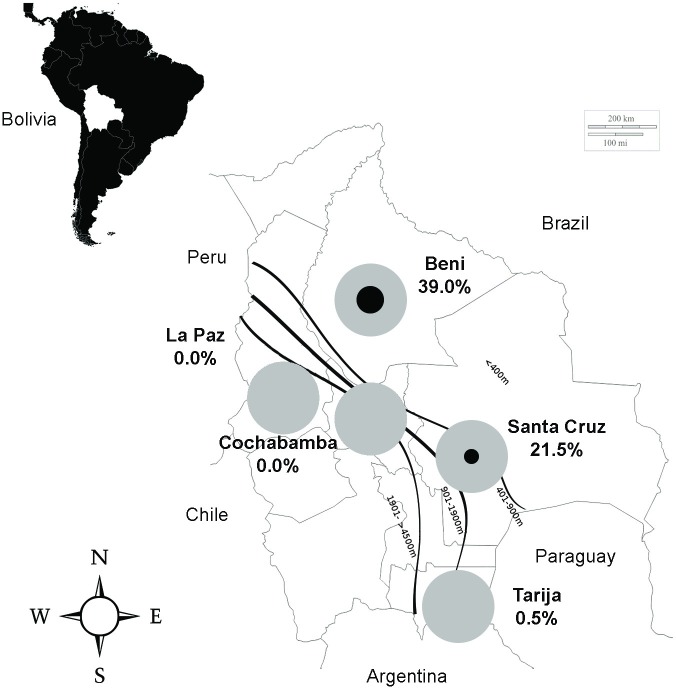
Zika virus seroprevalence in Bolivian volunteer blood donors.Samples were collected in December 2016 (Beni) and from March to April 2017 (other regions). The figure shows in each of the five regions investigated the proportion of samples positives in both ELISA and Virus Neutralisation Test (the black circle represents the proportion of positives): Santa Cruz (altitude ~400m) and Beni (alt. ~150m) have tropical climate; Cochabamba (alt. ~2500m), Tarija (alt. ~1850m), and especially La Paz (alt. ~3650m) have colder subtropical highland climates.